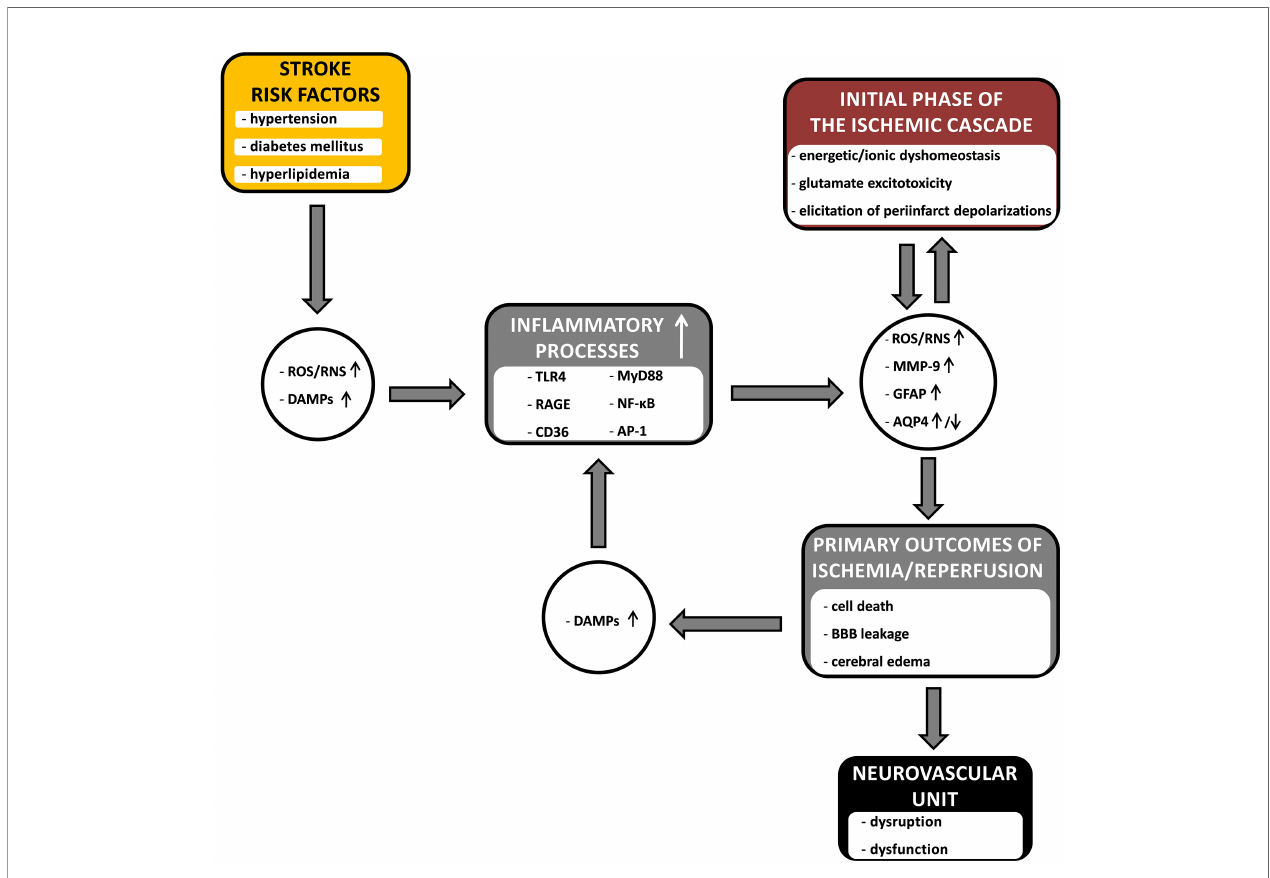
FIGURE 1 | The diagram showing the hypothetical links between common stroke comorbidities (arterial hypertension, diabetes mellitus and hyperlipidemia), in fl ammatory processes and the course of cerebral ischemia/reperfusion cascade. The comorbid risk factors enhance the in fl uence of the in fl ammatory processes on the course of the ischemia/reperfusion cascade, contributing to the processes leading to the damage and dysfunction of the neurovascular unit in the penumbra. In fl ammatory processes, together with the primary outcomes of the ischemic cascade, form a vicious cycle – where they constitute an amplifying point, and the connecting bridge point, between risk factors and the ischemic cascade. The detailed description is provided in the text. ROS, reactive oxygen species; RNS, reactive nitrogen species; DAMPs, danger associated molecular patterns; TLR4, toll like receptor 4; RAGE, receptor for advanced glycation end products; CD36, platelet glycoprotein 4; MyD88, myeloid differentiation primary response protein (innate immune signal transduction adaptor); NF- k B, nuclear factor kappa B; AP-1, activator protein 1; MMP-9, matrix metalloproteinase-9; GFAP, glial fi brillary acidic protein; AQP4, aquaporin-4; BBB, blood-brain barrier; ↑ , upregulation; ↓ ,